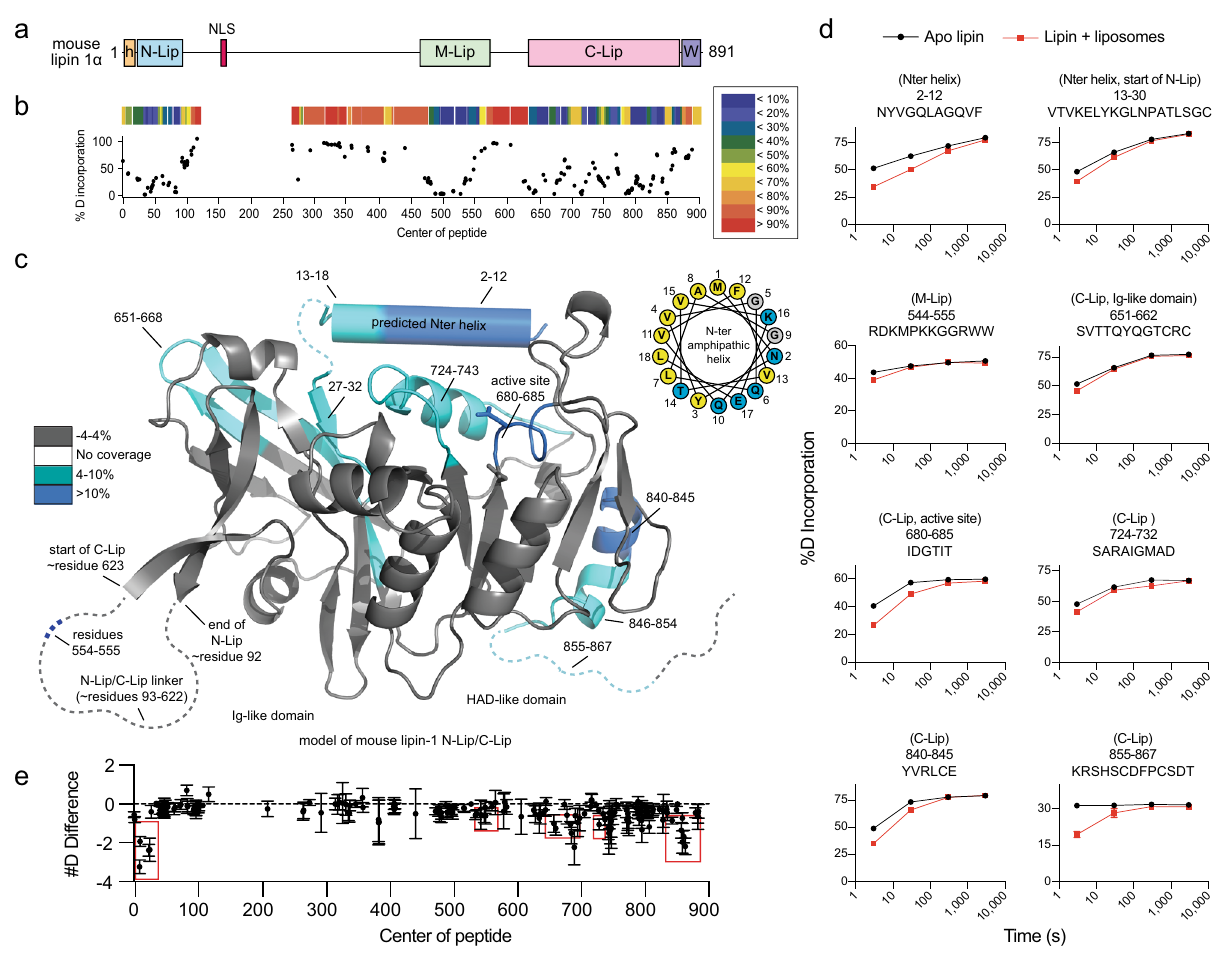
Fig. 1 Structure and dynamics of lipin 1. a Domain architecture of mouse lipin 1 drawn to scale. Mammalian lipins conserve three regions/domains: the N- Lip, M-Lip, and C-Lip. The N-Lip and C-Lip are predicted to co-fold to form two domains: an Ig-like and HAD-like domain. The positions of the N-ter amphipathic helix (orange h), nuclear localization signal (NLS), and conserved Trp-motif (purple W) are indicated. b % deuterium incorporation after a 3 s (on ice) deuterium exposure in the absence of liposomes. Each point represents a single peptide, with them being graphed on the x -axis according to their central residue. A heat map above is color coded according to the legend. c Regions of lipin 1 that showed signi fi cant decreases in exchange (de fi ned as >4%, >0.4 Da, and a two-tailed student t -test p < 0.01) in the presence of liposomes are colored in blue according to the legend and shown on a model of the N-Lip and C-Lip regions generated by Phyre2. Regions not modeled are shown as dashed lines. Helical wheel diagram (top right) of the putative N- terminal amphipathic helix. Hydrophobic residues, yellow; polar residues, blue; glycine residues, gray. d % deuterium incorporation of selected peptides at various time points (3, 30, 300, and 3000 s) in the absence and presence of liposomes. Data are presented as mean values ± SDs. n = 3 independent experiments. Most SDs are smaller than the size of the point. e The sum of the # of deuterons protected from exchange in the presence of liposomes across all timepoints is shown. Each point represents a single peptide, with them being graphed on the x -axis according to their central residue. Data are presented as mean values ± SDs. n = 3 independent experiments. Source data are provided as a Source data fi